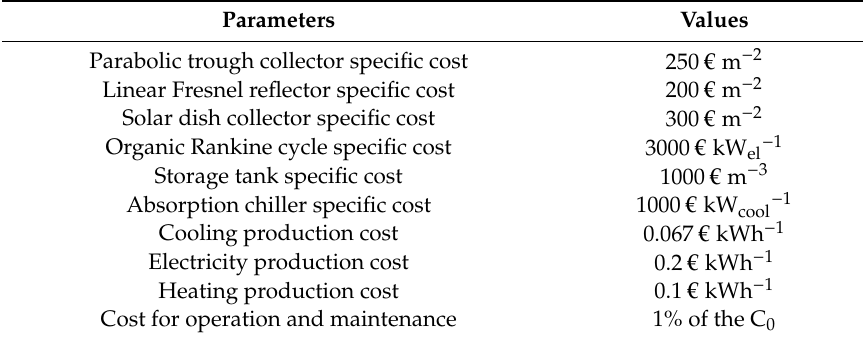
Table 3. Economic input data of the present paper [36,41].